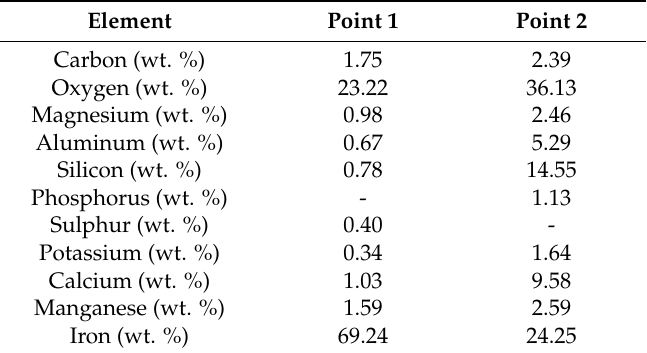
Figure 8. SEM-EDX for the sample Sint4. Table 6. Point analysis for the sample